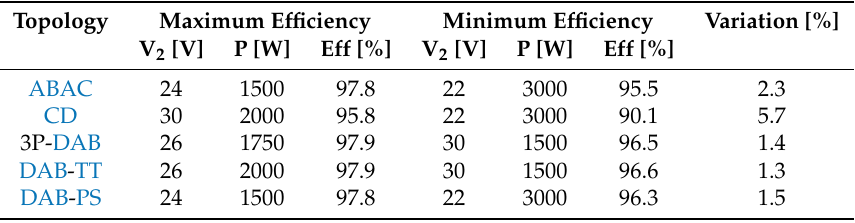
Table 8. Maximum and minimum nominal output voltage efficiency map values in boost mode.